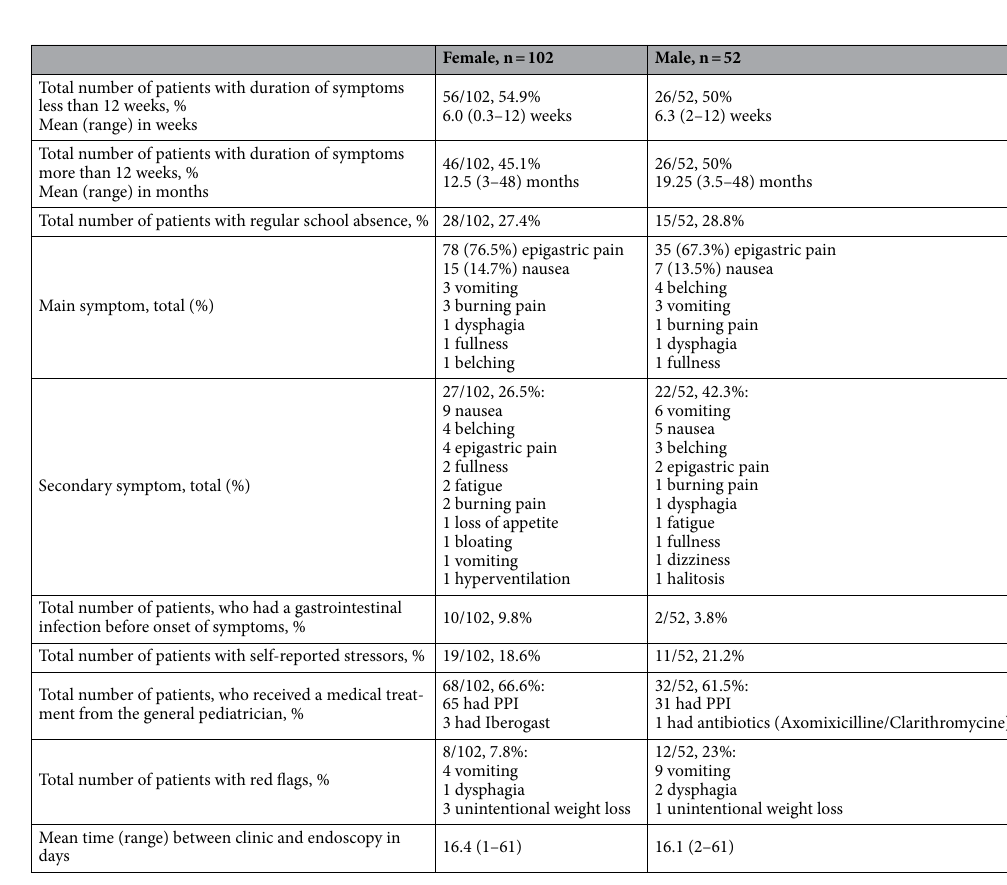
Table 2. Description of the